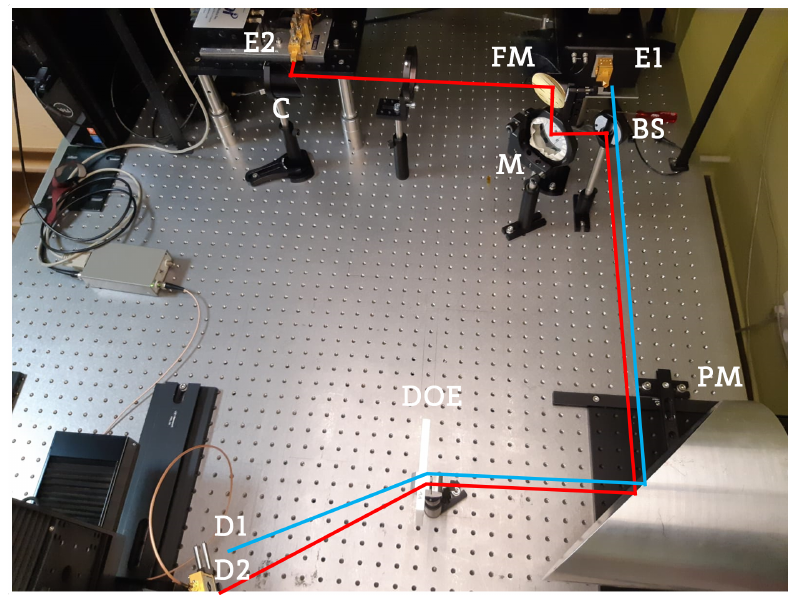
Figure 8. The optical setup used for verification of the spatial separation of signals with frequencies of 300 GHz and 330 GHz. E1 and E2—emitters, C—collimator, FM—focusing mirror, M—flat